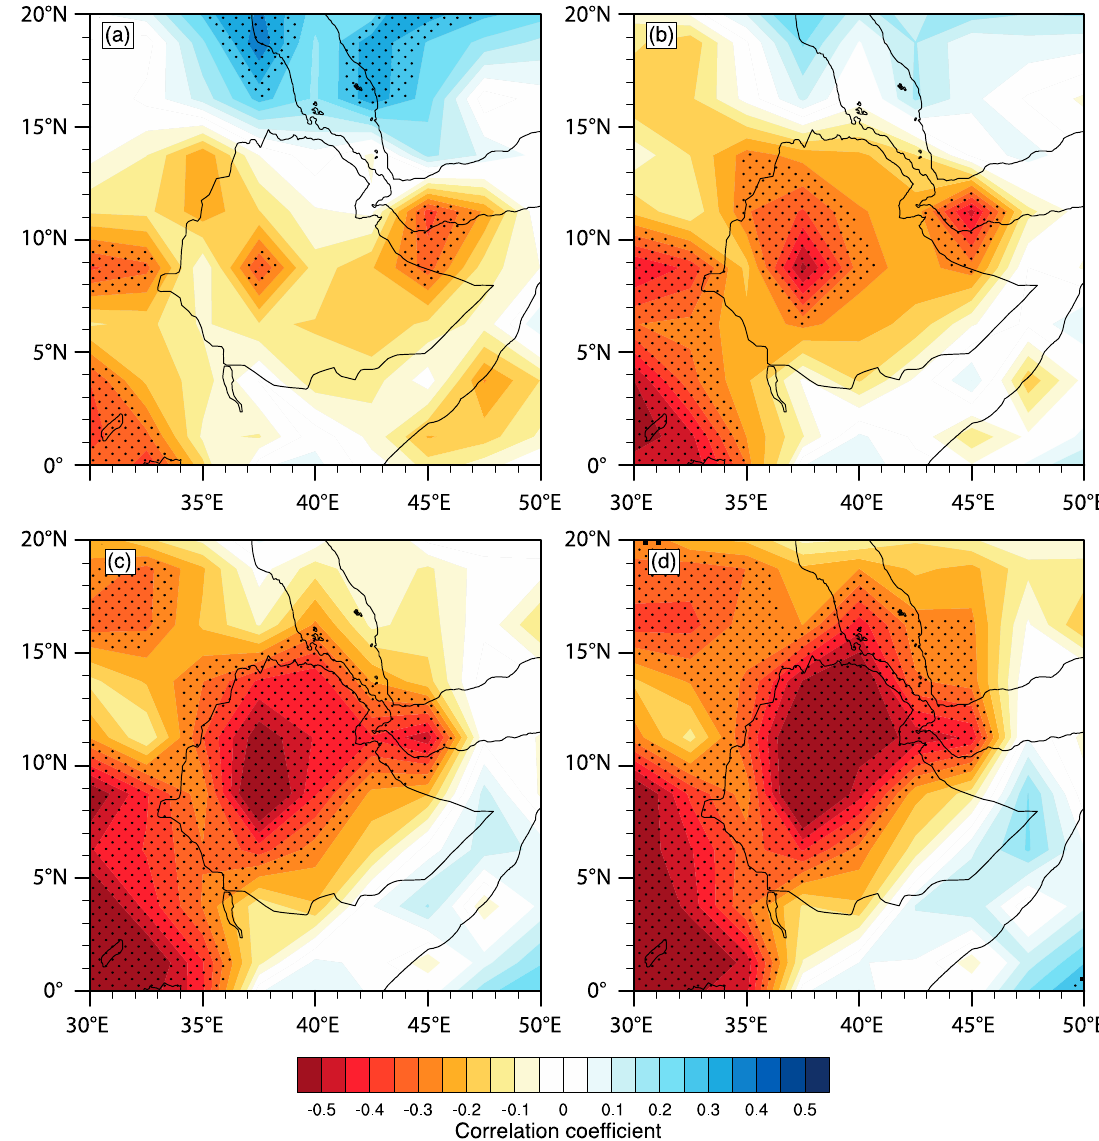
Figure 9. Comparisons of the lagged correlation between Kiremt rainfall and NINO3.4 index during ( a ) March–May (MAM), ( b ) April–May (AMJ), ( c ) May–July (MJJ), and ( d ) June–August (JJA). Dotted points indicate statistically significant grid points at the 95% confidence level (one-tailed test).